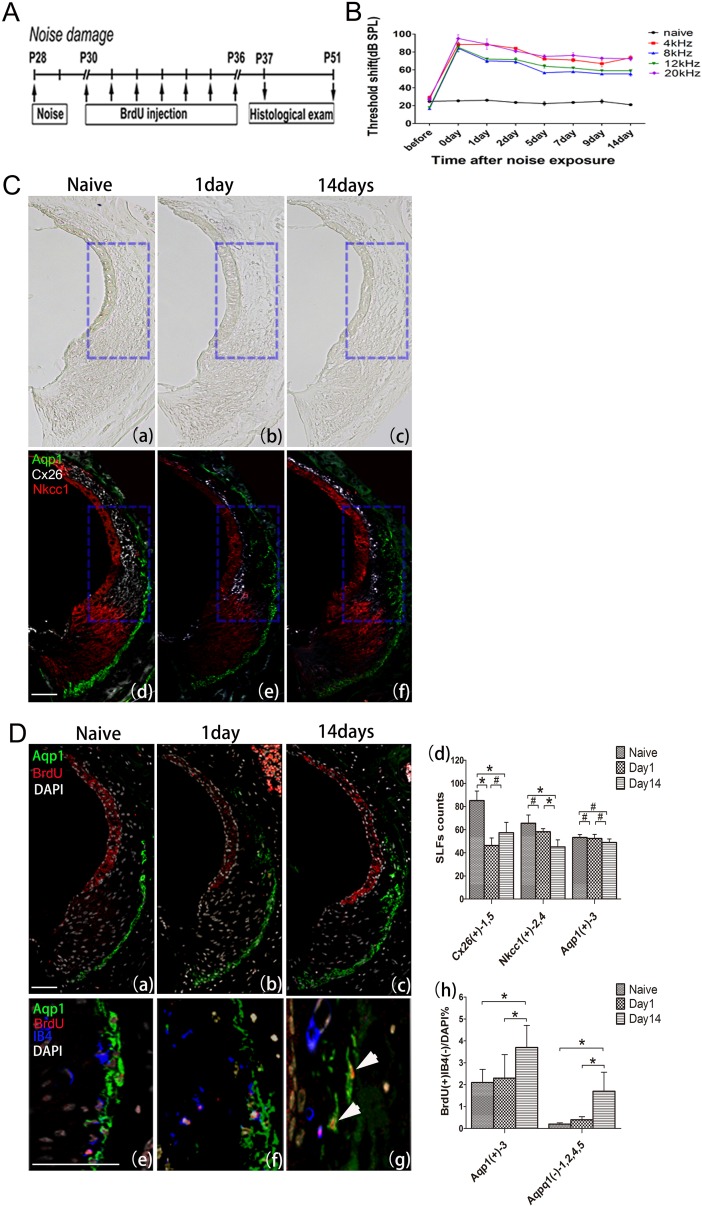
Proliferation of SLFs after intense sound exposure.Experimental design indicating the duration of BrdU treatment and observation time points in noise-damaged mice (A); Time course of threshold shifts following exposure to a 120 dB SPL of octave band noise for 2h (B); Histological evaluation (C(a-c)) and triple immunostaining for NkCC1/Cx26/Aqp1 (C(d-f)), BrdU/IB4/Aqp1 (D(e-g)) were performed at 1 day and 14 days after noise exposure. Some BrdU+IB4- type 3 SLFs even entered type 1 area (D(g)). The number of type 3 fibrocytes did not change significantly (D(d)), but the number of BrdU incorporating type 3 fibrocytes increased during the time-course (D(h)). Arrow heads: BrdU+IB4-Aqp1+ fibrocytes. #P > 0.05, *P < 0.05. Scar bar = 100μm.